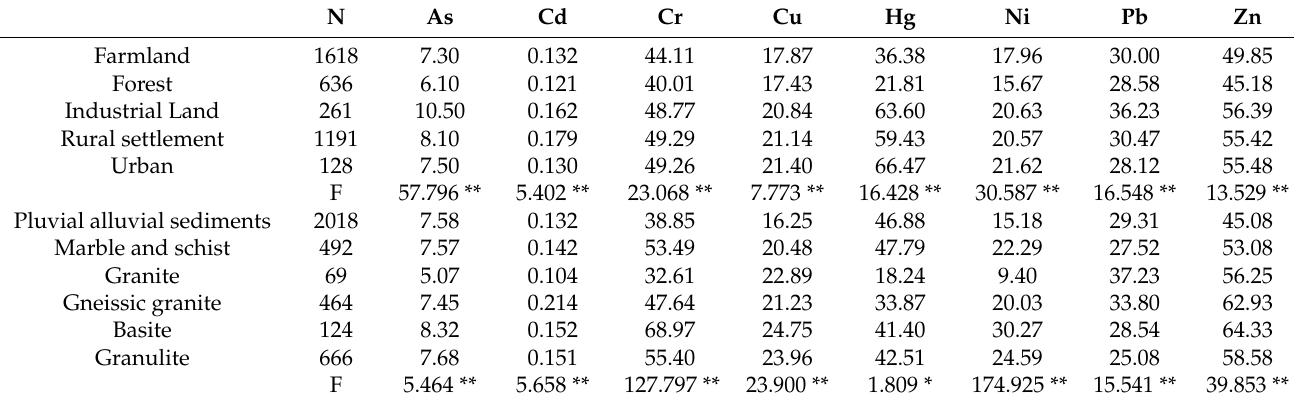
Figure 8. Degree of Composite Potential Ecological Risk of Heavy Metals in Surface Soil. Table 8. Results of Analysis of Variance (ANOVA) for the Concentration of Heavy Metal in Surface Soils by Land Use and Parent Material